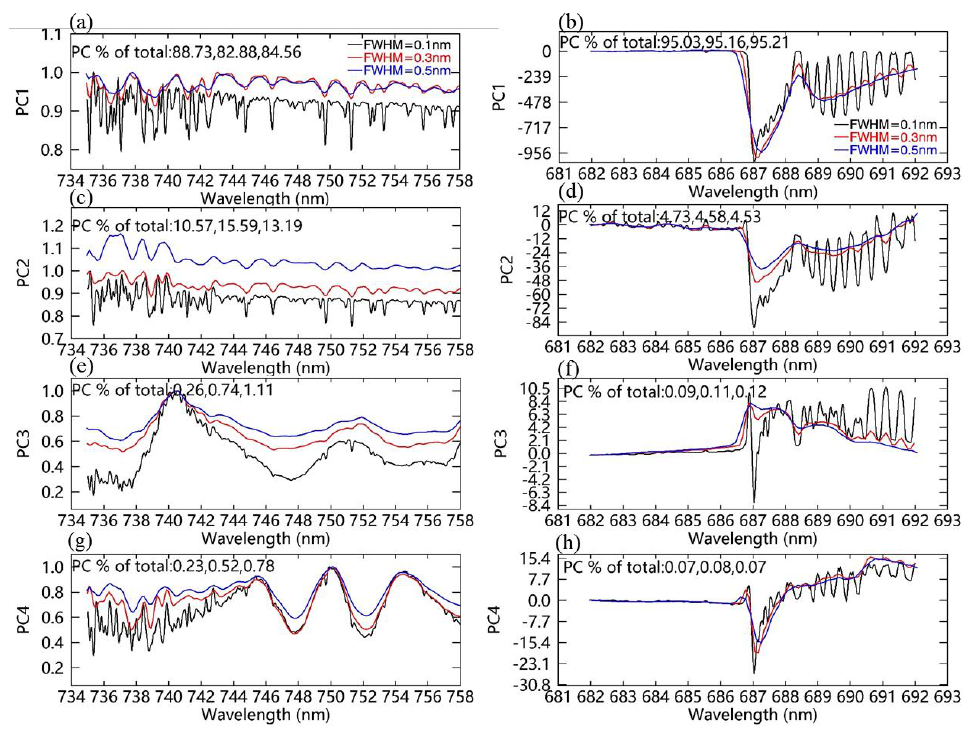
Figure 7. The leading four principal components (PCs) of noise-free simulated spectra for different SRs of 0.1 nm (black), 0.3 nm (red), and 0.5 nm (blue). ( a , c , e , g ) are the first leading PCs for the far-red band, and ( b , d , f , h ) are the first leading PCs for the red band. The explained variances of each PC for three SRs are also listed at the top of each graph.